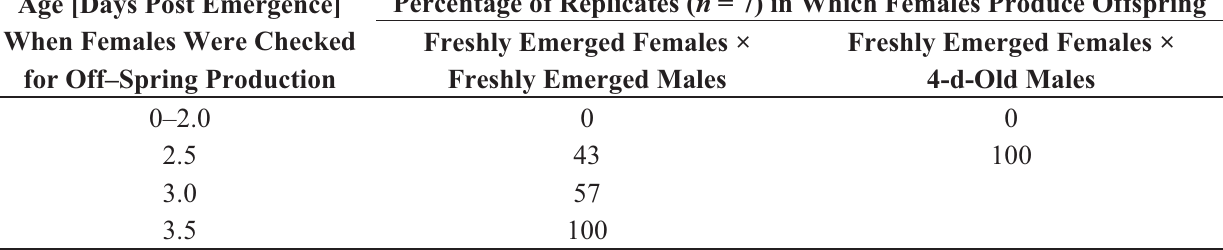
were either continously kept with males of same age or they were kept for only 24 h with 4-d-old male D. suzukii (showing that females can get inseminated within 24 h after emergence by mature males)